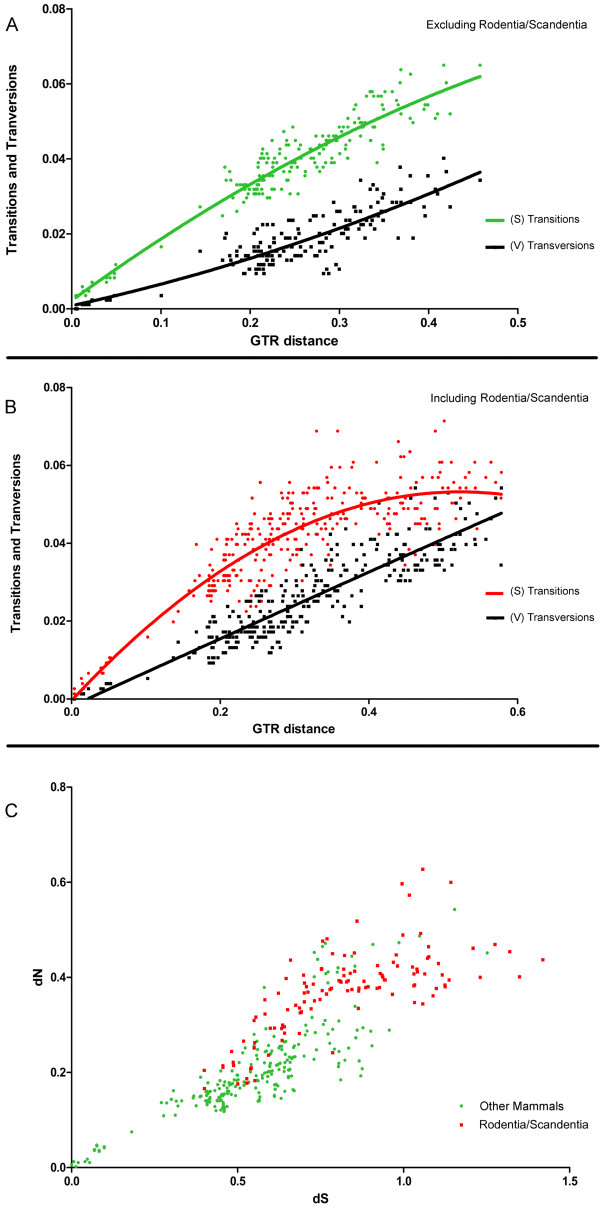
Accumulation of saturation and altered evolutionary rate in Rodentia and Scandentia compared with other mammals. (A) Nucleotide saturation plots excluding rodents and the tree shrew, showing transitions (S) and transversions (V) accumulated in the third position; and the same analysis (B) including the rodents and the tree shrew (C) Pairwise dN/dS comparison of rodents and the other mammals.